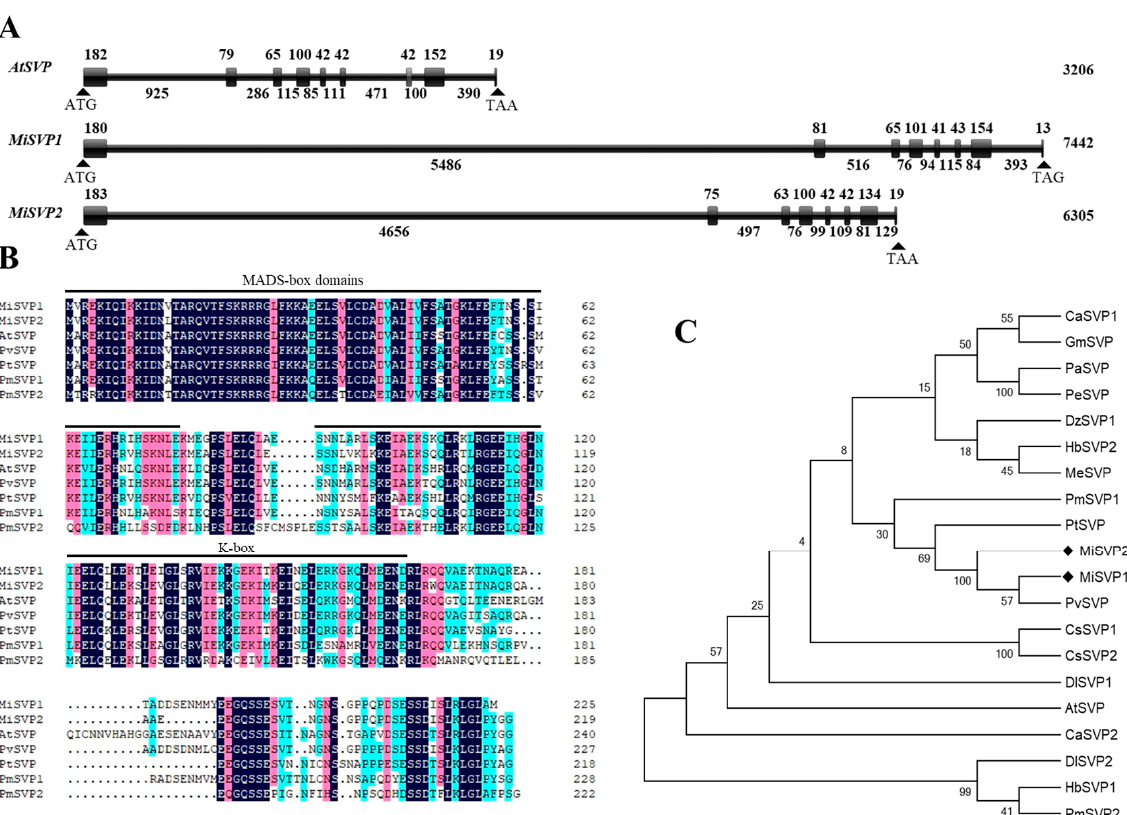
Figure 1. Sequence, structural, and phylogenetic analyses of MiSVP1 and MiSVP2. ( A ) Schematic diagram of intron/exon structures of MiSVP1, MiSVP2 , and AtSVP . The lines represent introns, and the boxes represent exons. The number represents the length of the exons/introns in base pairs. ( B ) Multiple amino acid sequence alignment of MiSVPs and SVP-like proteins in different species. The underscores denote the MADS-box and K-box domains. Black indicates that the sequences are identical, red indicates ≥ 75% similarity, and blue indicates ≥ 50% similarity. ( C ) Phylogenetic analysis of SVP proteins from mango and other species. MiSVP1 and MiSVP2 are marked by black diamonds. The protein sequences used in this study were downloaded from NCBI, and were as follows (gene accession numbers in parentheses): CaSVP1 ( Coffea arabica , AHW58026), CaSVP2 ( Coffea arabica , AHW58042), GmSVP ( Glycine max , NP_001240951), PaSVP ( Populus alba , XP_034933033), PeSVP ( Populus euphratica , XP_011021845), DzSVP1 ( Durio zibethinus , XP_022751126),